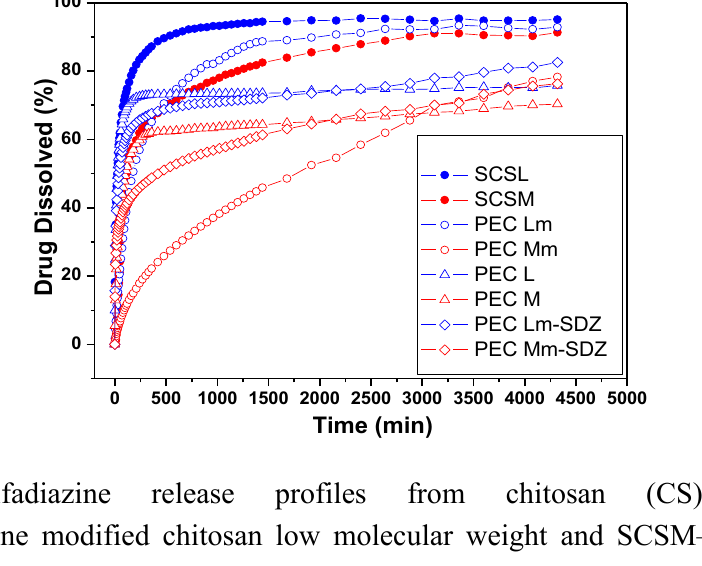
Figure 8. Sulfadiazine release profiles from chitosan (CS) conjugates